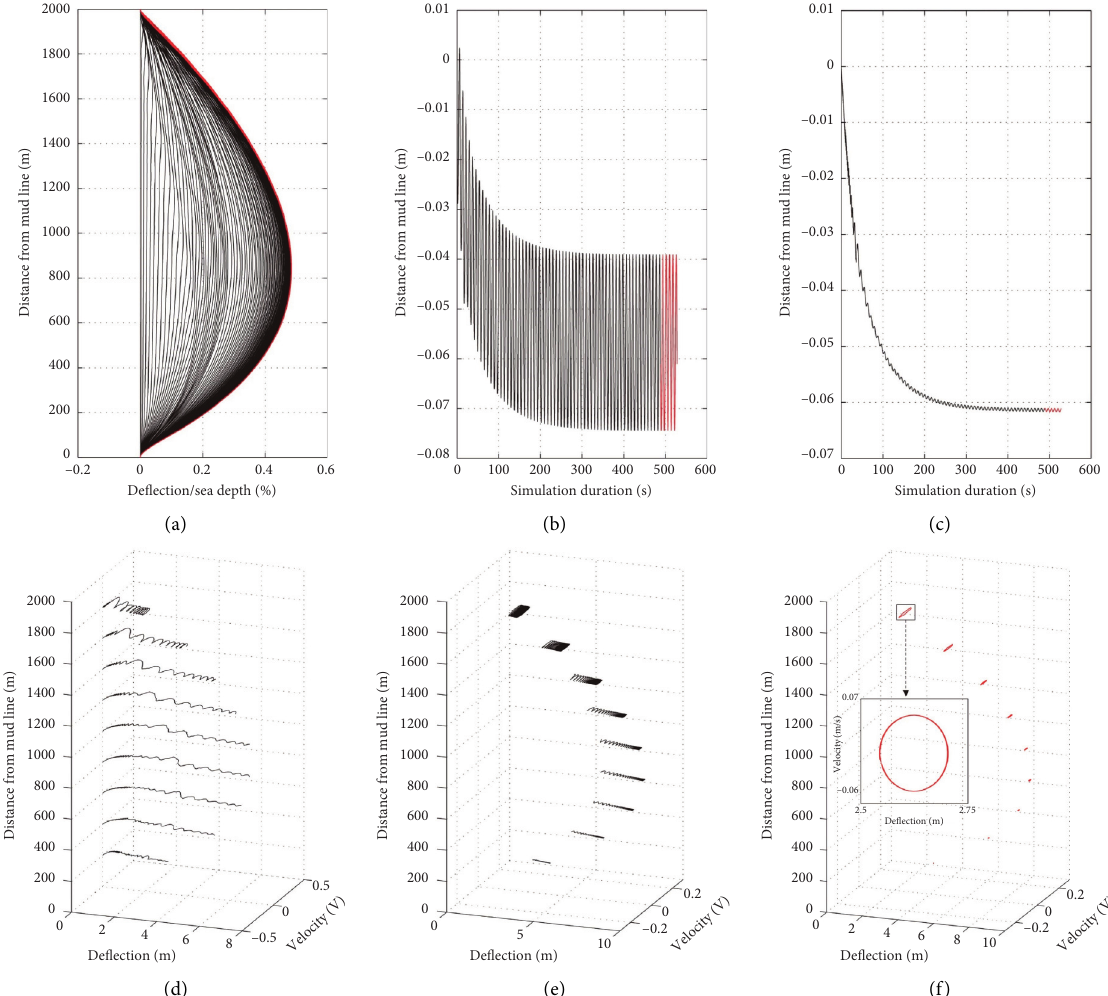
Figure 4: Dynamic responses for an offshore drilling riser with 2000m during the numerical simulation in 0 ∼ 300 s, (a) distribution of lateral deflection, (b) time history of deflection angle of the upper joint, and (c) that of the bottom joint. The vibration trajectories of the riser in every 200m depth are displayed for (d) fast lateral deflection phase, (e) reciprocating deflection phase, and (f) dynamic stable condition phase,